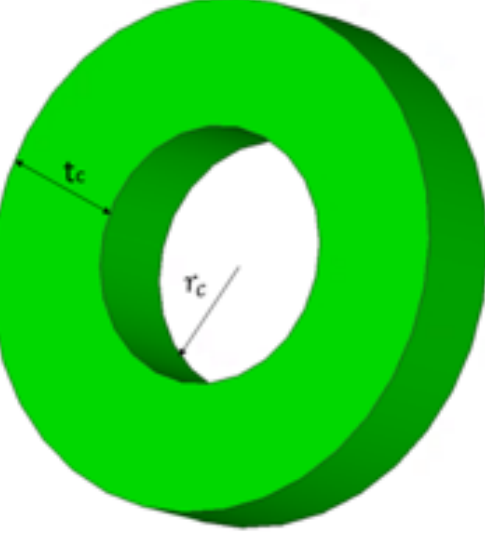
Figure 15. Unit cell of the perforated top substrate.